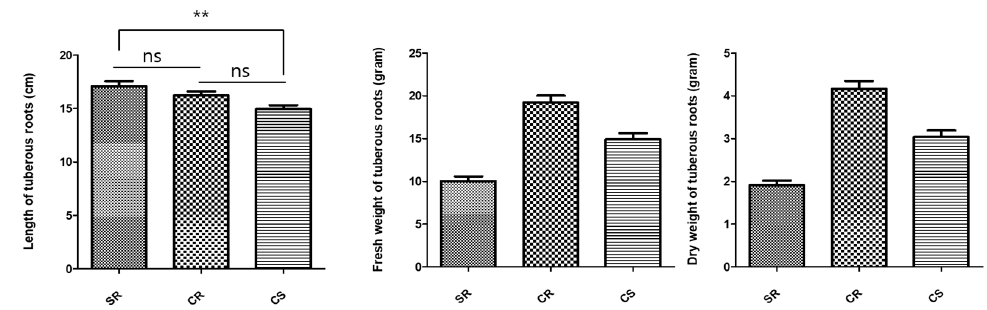
Figure 3. Comparison of root morphology of the different seedling types. SR, Standard Rootstock seedling. CR, Culture Rootstock seedling. CS, Culture seedling. The scale bar indicates 1.0 cm.